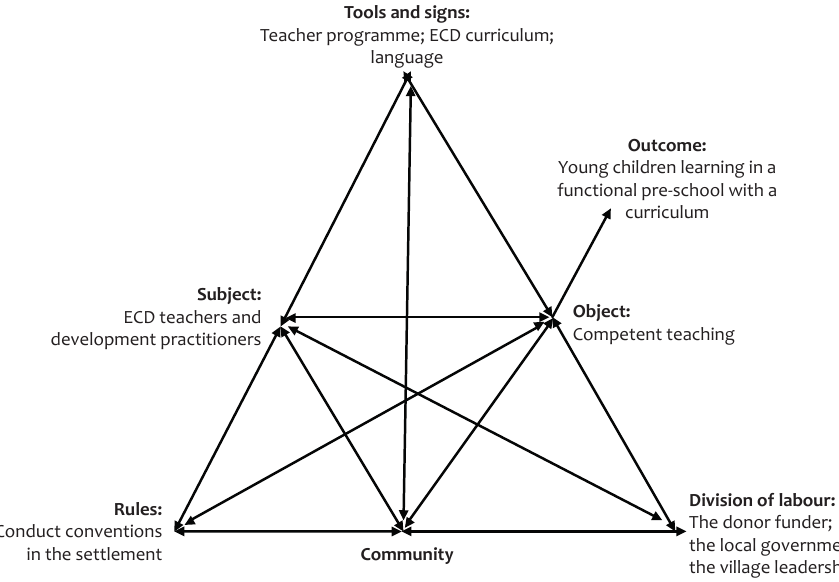
Figure 1: Relationships between elements of an activity system: the emergent Mogwase ECD project (adapted from, Engeström,